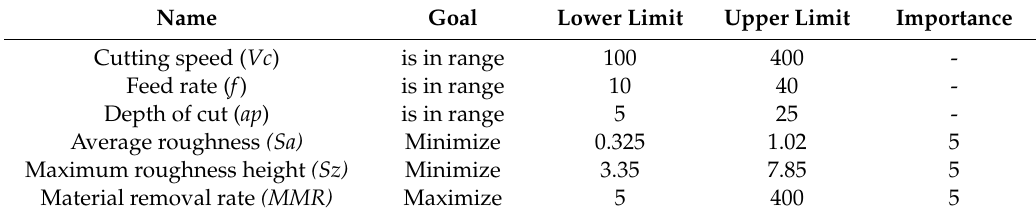
Table 11. Inputs, outputs, ranges and the importance for the optimization.